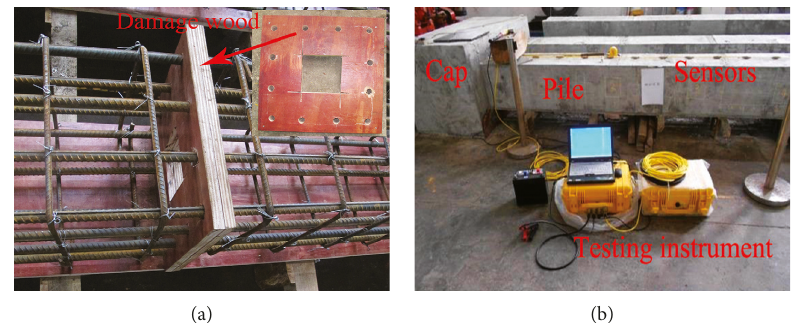
Figure 5: Experimental test setup. (a) The damage of the two-pile model. (b) Testing instrument.